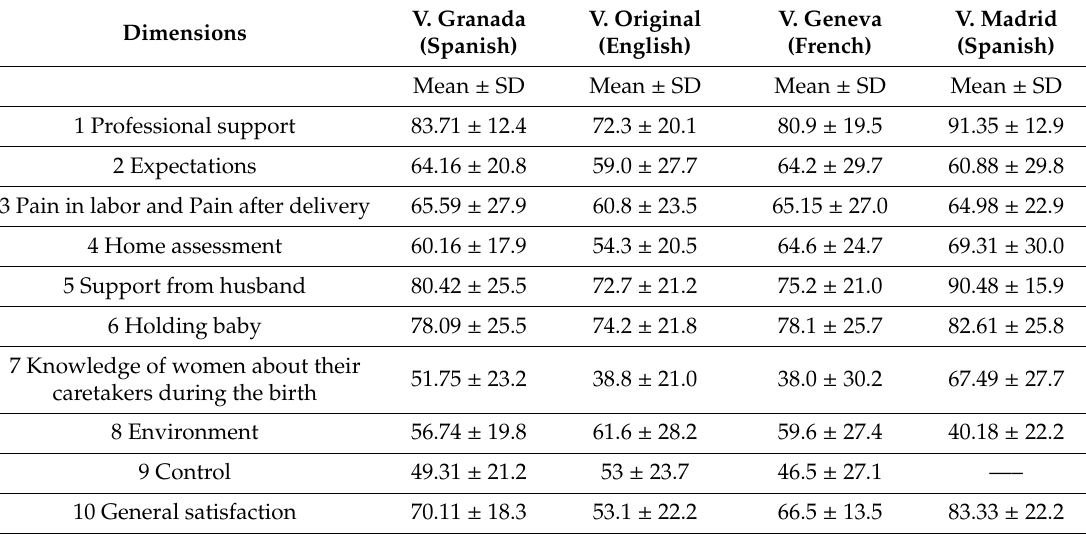
Table 5. Average scores in the di ff erent